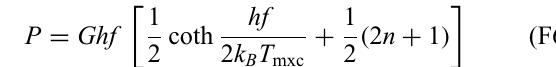
FIG. 11. Planck spectroscopy calibration. Noise power as a function of temperature at the frequency of mode f 2 (3.858